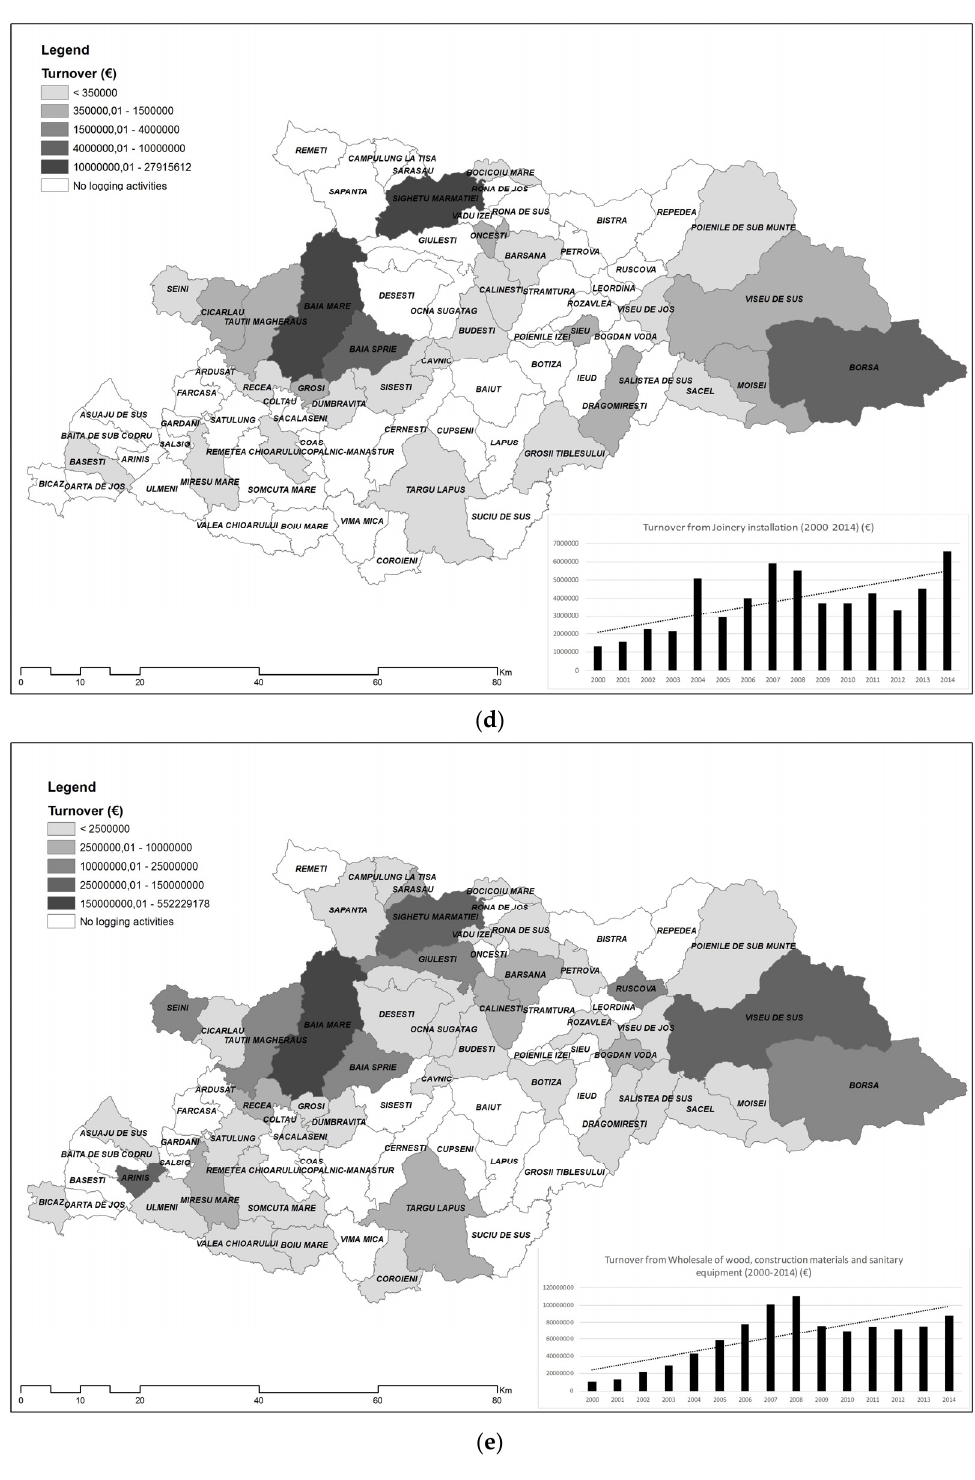
Figure 7. ( a ) Turnover from sylviculture and other forestry activities (NACE Code 0210). ( b ) Turnover from logging activities (NACE Code 0220). ( c ) Turnover from Sawmilling and planting of wood activities (NACE Code 1610). ( d ) Turnover from Joinery installation (NACE Code 4332). ( e ) Turnover from wholesale of wood, construction materials, and sanitary equipment (NACE Code 4673).